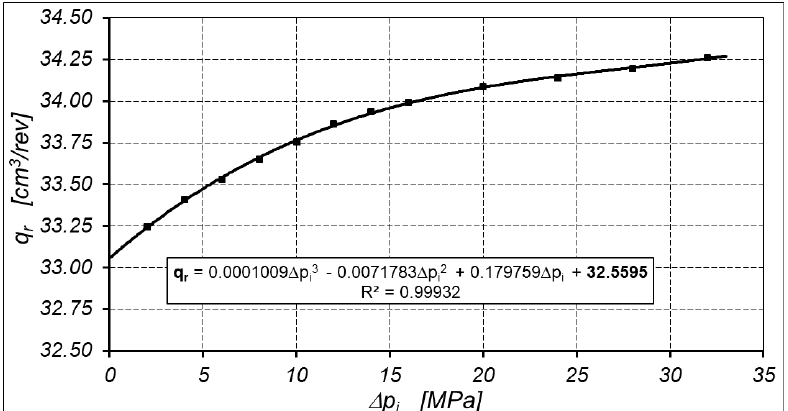
Figure 16. Characteristics of working volume q r as a function of pressure drop Δ p i in the motor working chambers (according to the new method).